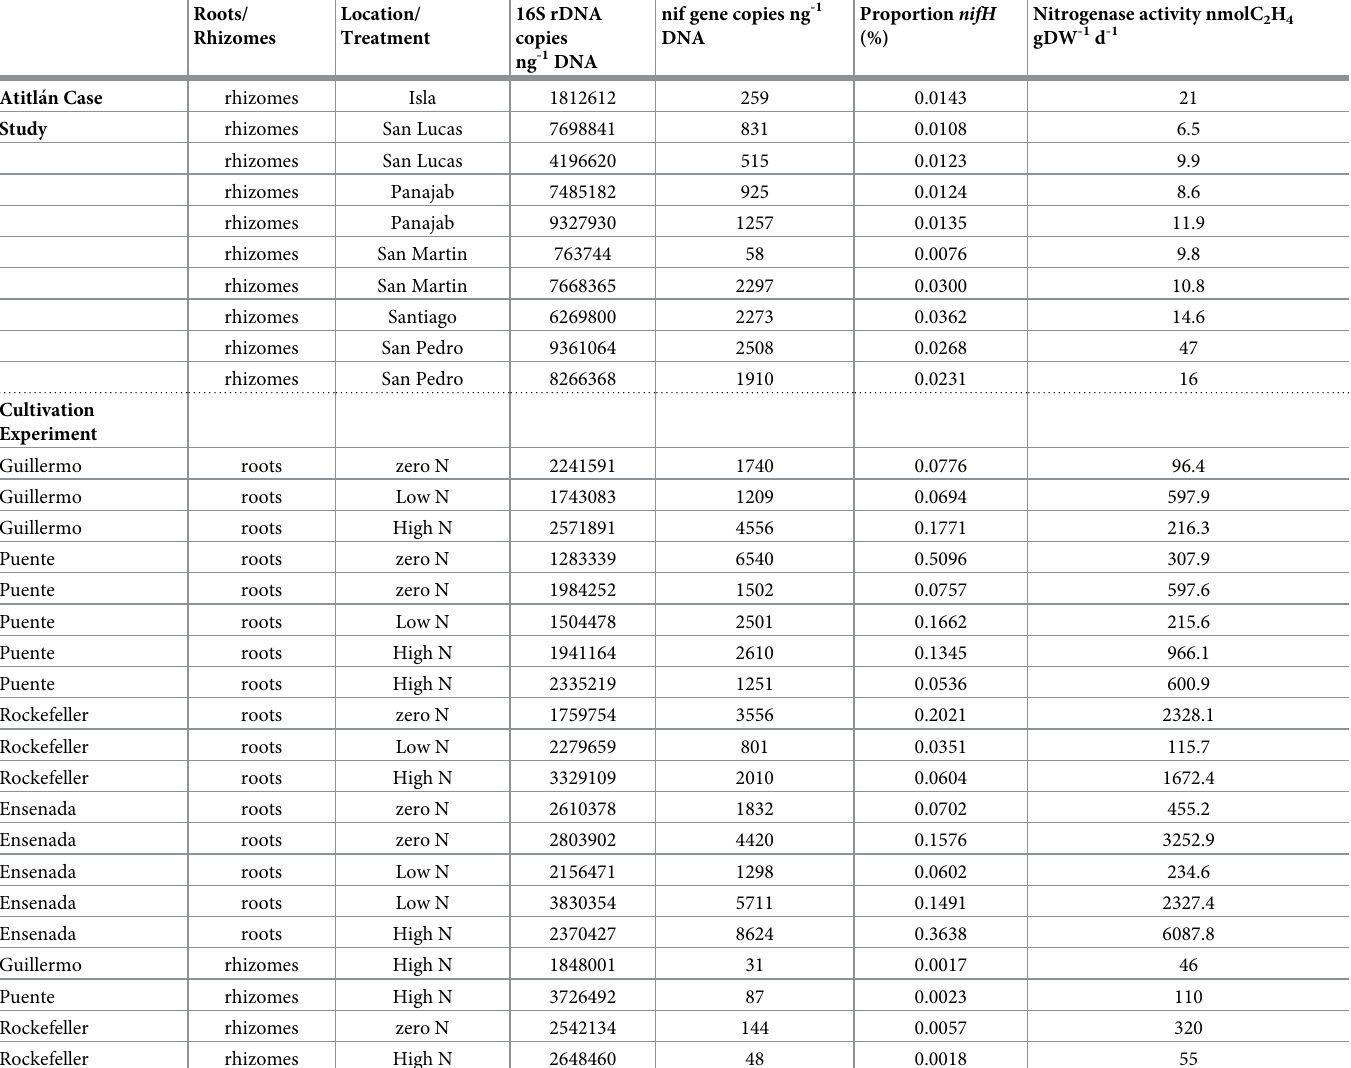
Table 5. Nitrogenase activity of epiphytic (roots) and endophytic (rhizomes) diazotrophs measured as ethylene production (nmol C 2 H 4 gDW -1 d -1 ) associated with Schoenoplectuscalifornicus from unpolluted and polluted locations in the littoral of Lake Atitla´n, Guatemala and with its selected varieties in different nutrient treatments of the cultivation